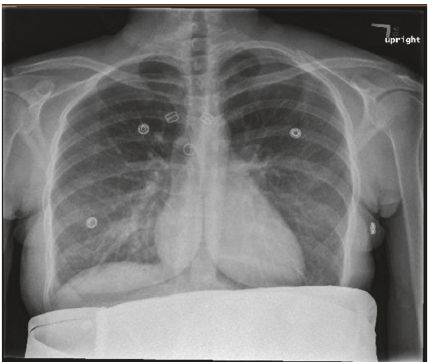
Figure 1: Chest radiograph on the day of admission noted indistinct increased markings and a patchy opacity in the right lower lung.